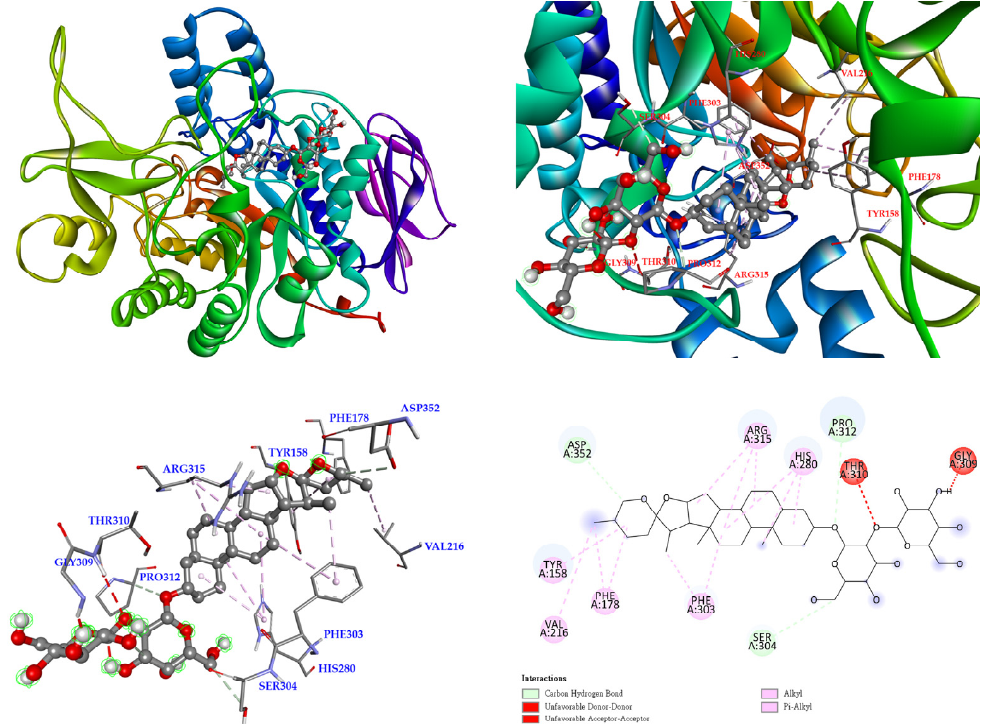
Figure 6. Interaction of timosaponin A-III with active sites of S. cerevisiae α -glucosidase.